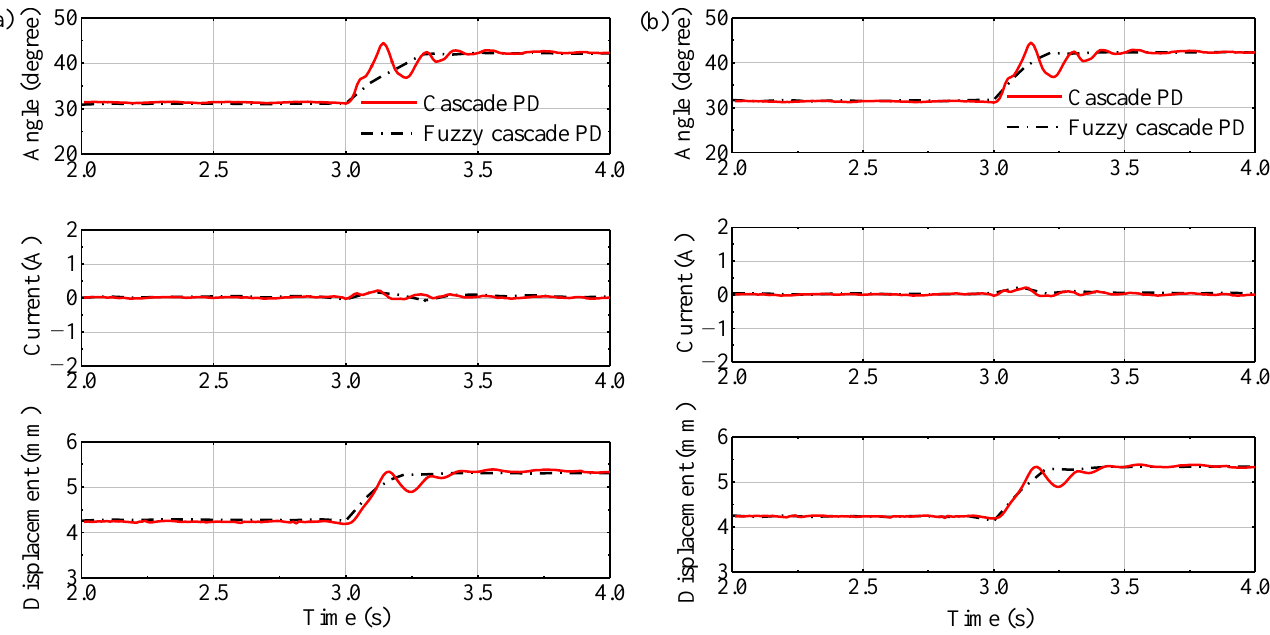
Figure 10. Experimental results of the force disturbance: ( a ) position loop fuzzy cascade control; ( b ) angle loop fuzzy cascade control. Table 4. Comparison results of the response